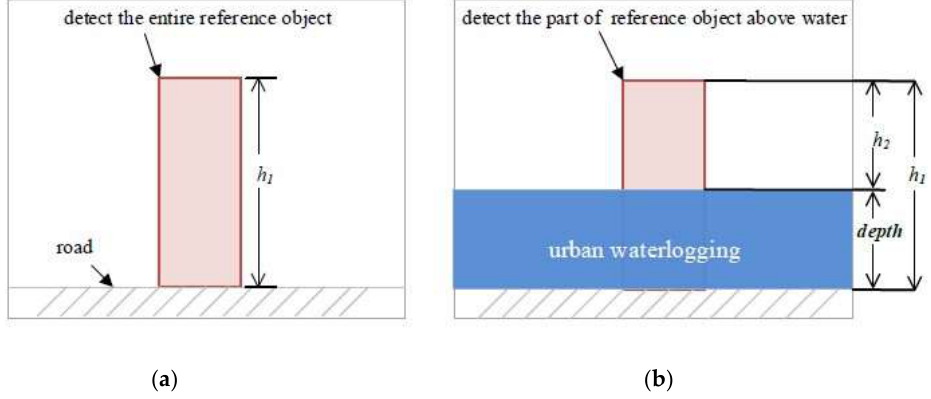
Figure 2. The video image in the non-flooding period ( a ), and the video image in the flooding period ( b ). h 1 is the height of the entire reference object, h 2 is the height of the part of the reference object above water, and depth is the waterlogging